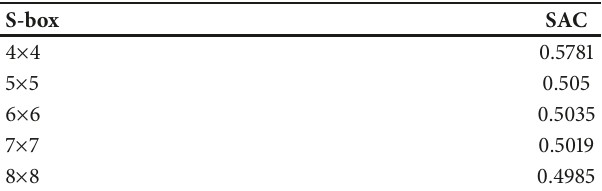
Table 11: SAC scores for the proposed bijective n × n S-boxes. Table 12: BIC-NL results for the proposed 8 × 8